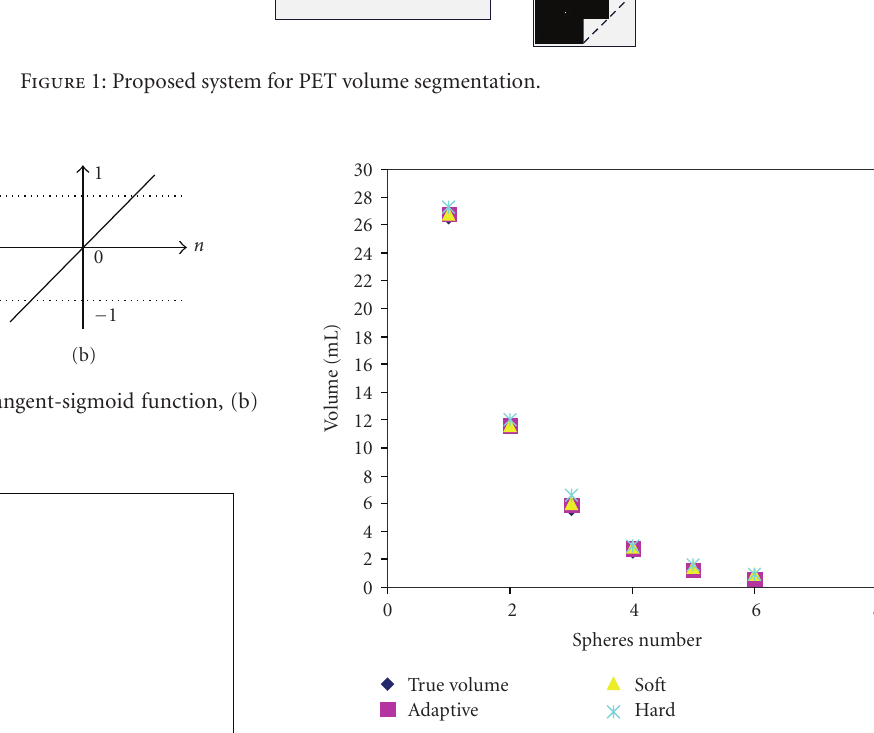
Figure 4: The segmented volume for all spheres in data set 1 using adaptive, soft, and hard thresholding approaches,